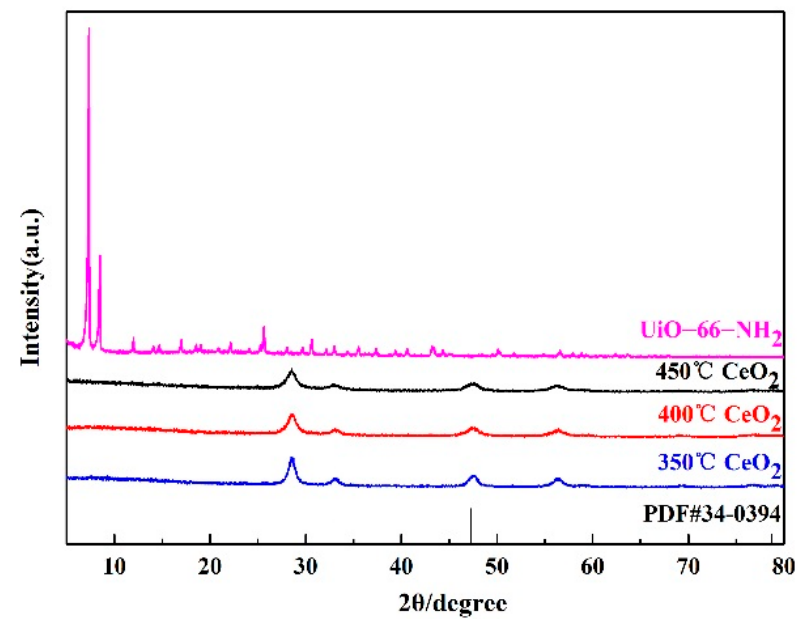
Figure 3. XRD patterns of CeO 2 prepared at different temperatures and UiO-66-NH 2 .